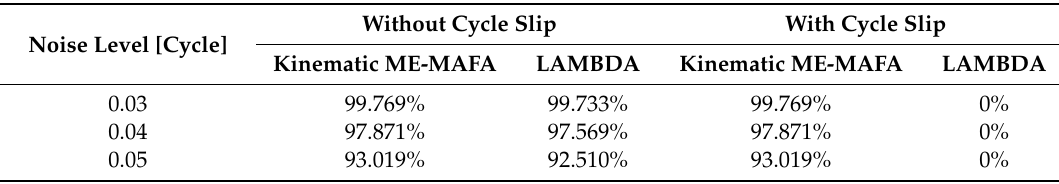
Table 3. Success rates with cycle slips.